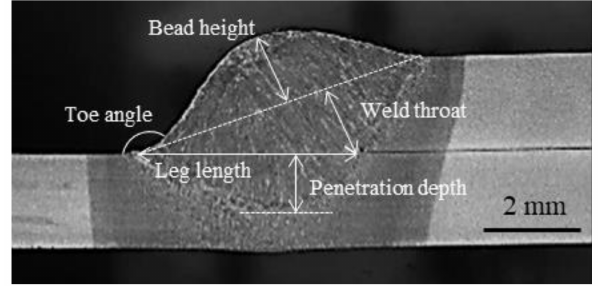
Figure 10. Measurement of weld size using length parameter.